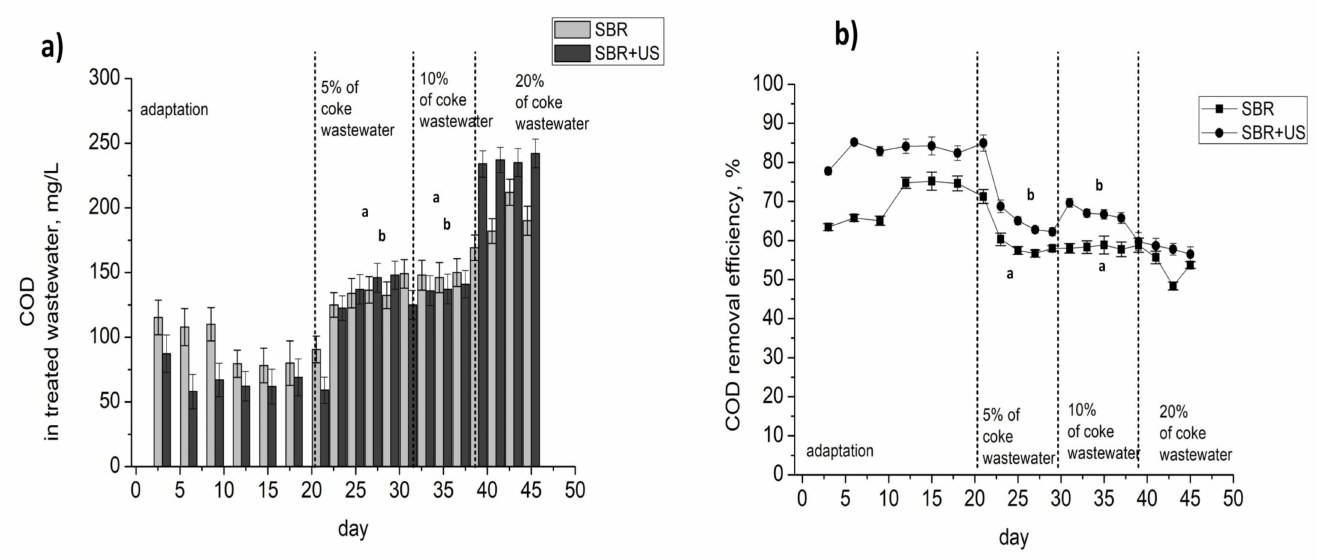
Figure 5. COD changes during treatment in the sequencing batch reactor (SBR): ( a ) concentration; ( b ) removal efficiency (Statistical group